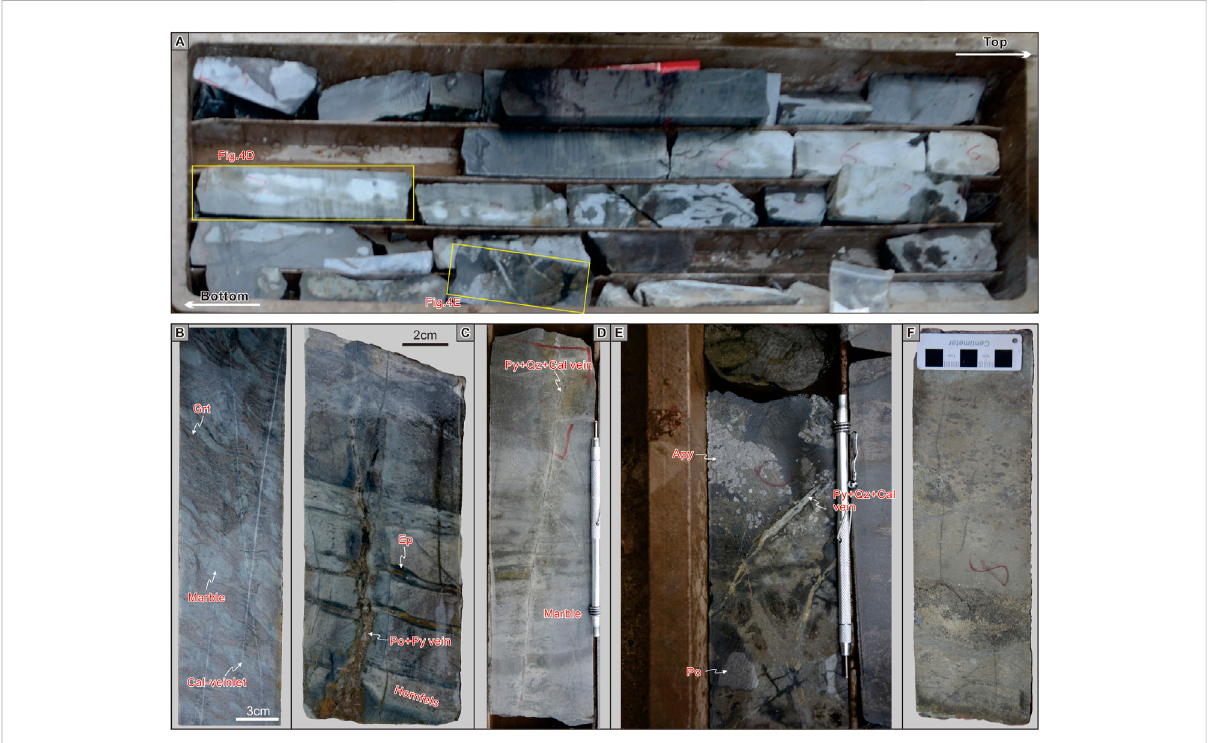
FIGURE 4 Photographs of representative ore and rocks within the Baimianshan Zn-Sn segment. (A) Core from drill hole ZK0801. (B) Massive garnet and marble were crosscut by steep-dipping calcite veins. (C) Steep-dipping branching veins or veinlets and layer-parallel massive ores overly on the layer-parallel marble and hornfels. (D) Steep-dipping pyrite-quartz-calcite veins crosscut the marble. (E) The arsenopyrite replaced the massive pyrrhotite-chalcopyrite-sphalerite and both were crosscut by the pyrite-quartz-calcite veins. (F) Massive pyrrhotite-chalcopyrite- sphalerite